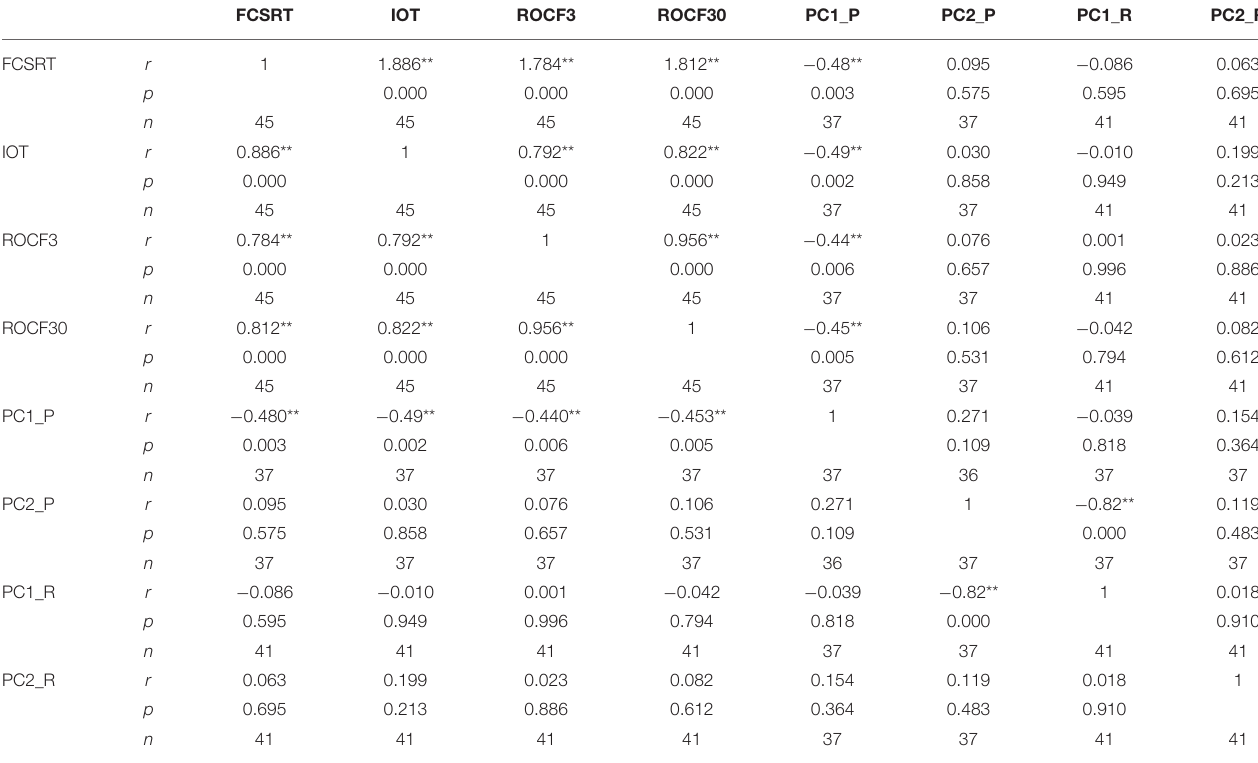
TABLE 4 | Correlation analyses for neurocognitive tests and principal components from Figures 6 , 7 .